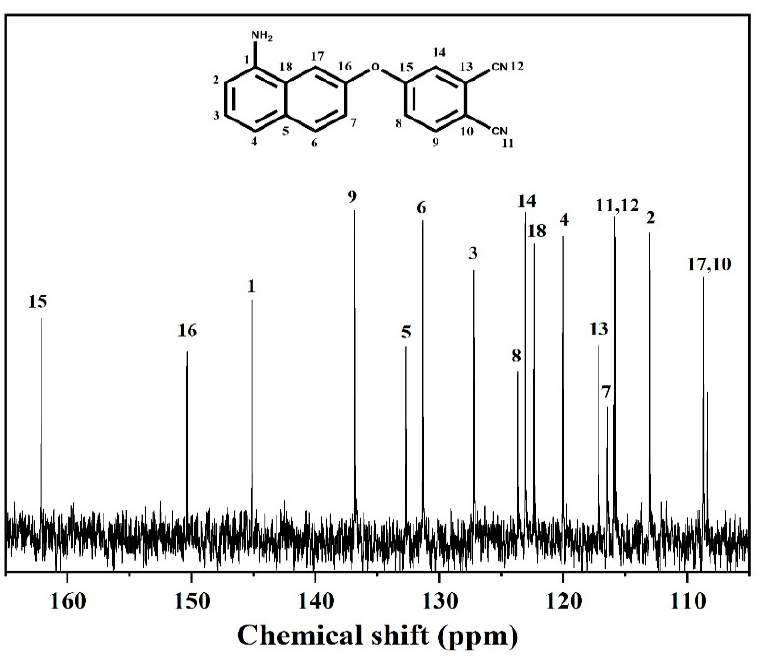
Figure 3. 13 C NMR spectrum of the ANP monomer.